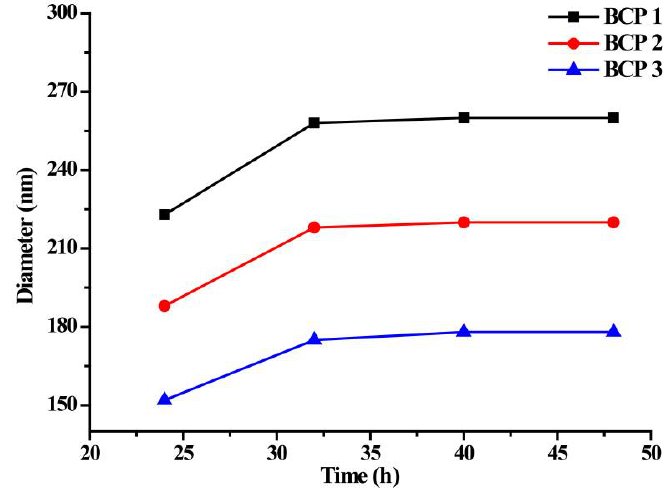
Figure 11. Hydrodynamic size of micelles versus time in FBS solution.